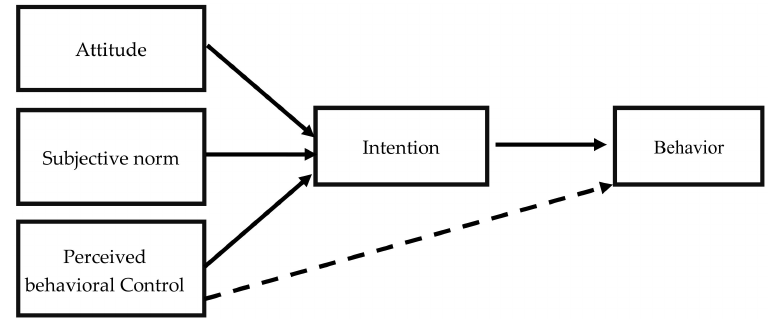
Figure 1. Theory of planned